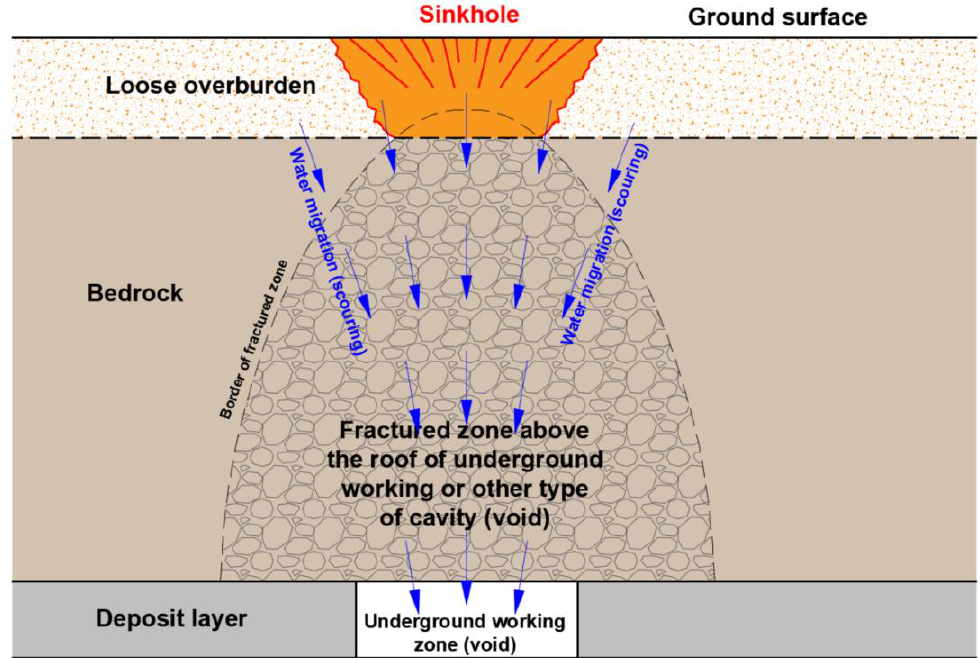
Figure 1. The common mechanism of sinkhole creation due to the existence of a shallow under- ground void.